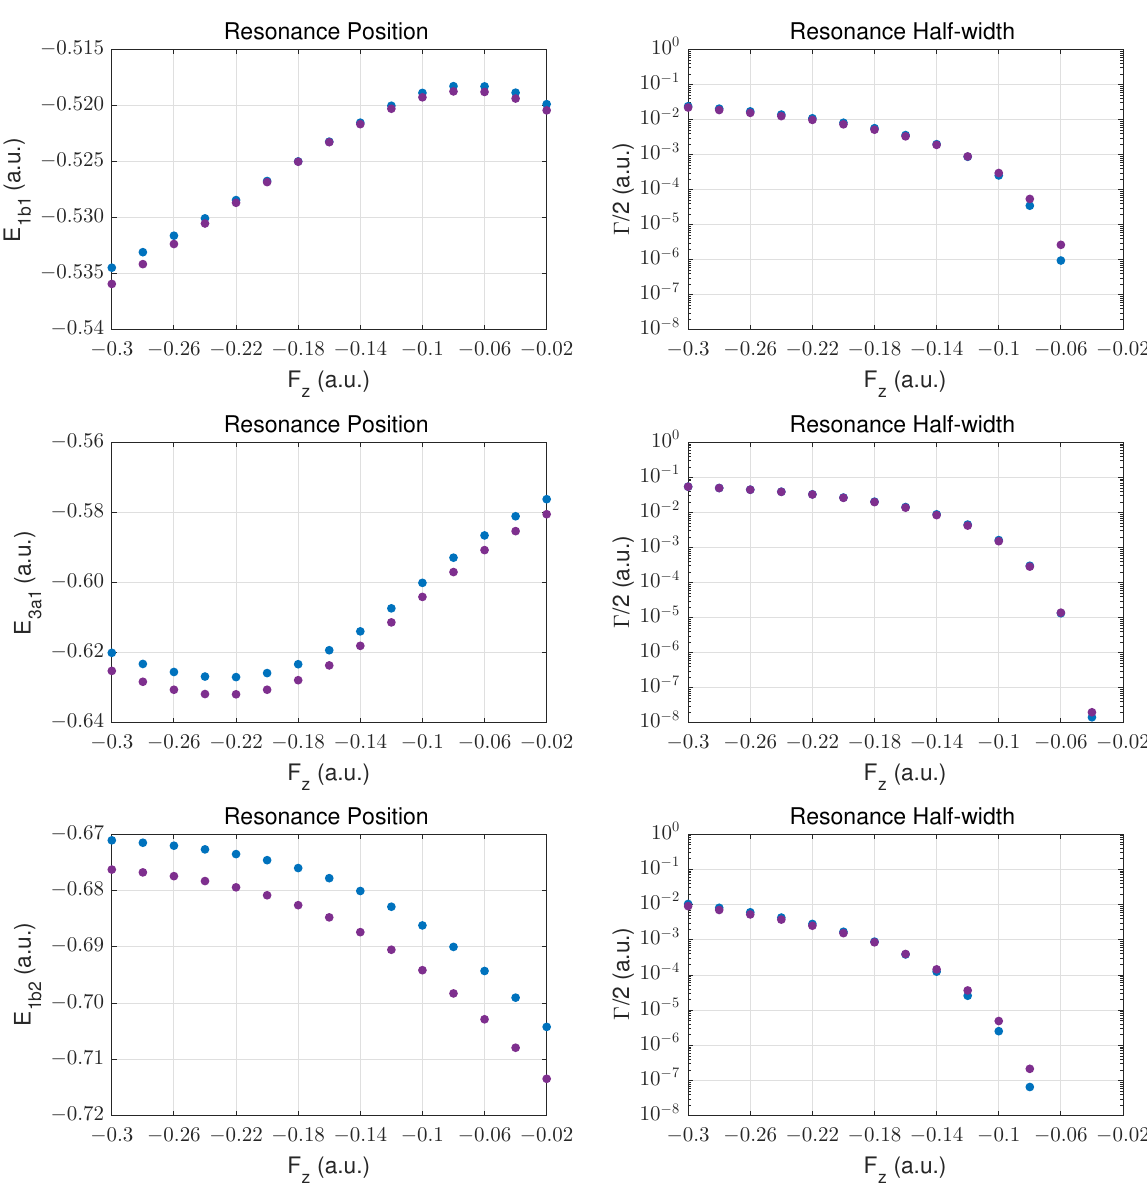
Figure 6. The left panel contains the resonance positions while the right panel contains half-widths for the valence orbitals of water in a DC field. Here, F z < 0 corresponds to a force experienced by the electron in the negative z direction. The (cid:96) max = 3 and (cid:96) max = 4 results are shown in blue ( • ) and purple ( • ),